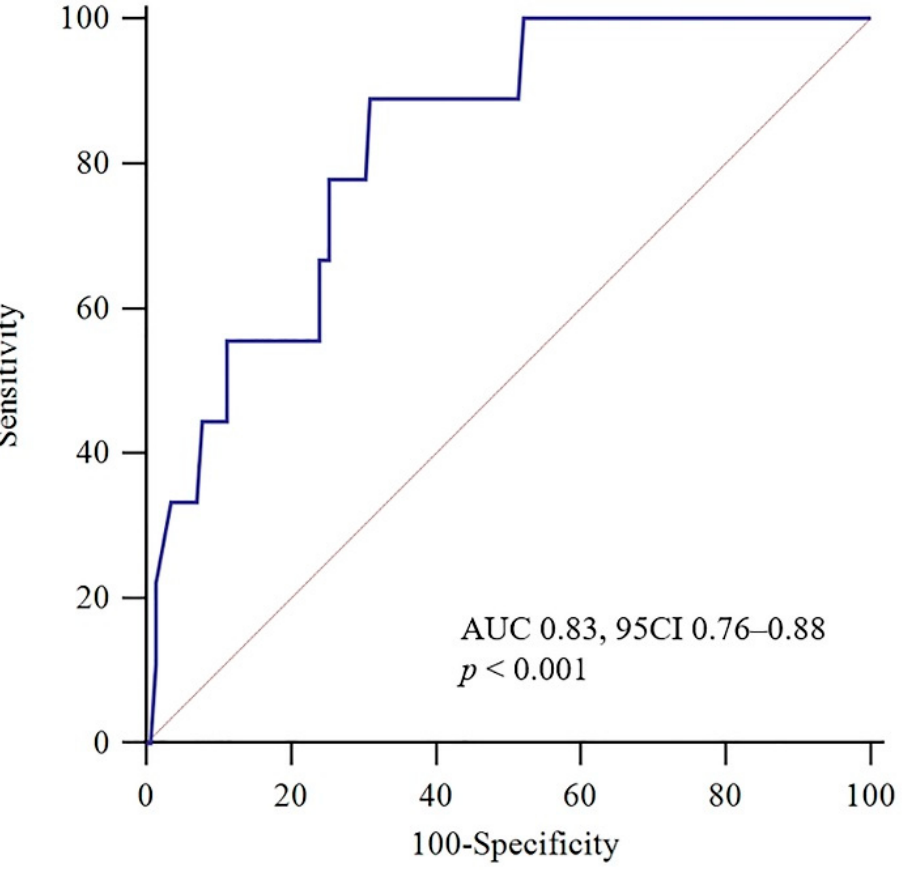
Figure 2. Receiver operating characteristic (ROC) curve for TRAIL concerning an adverse 30-day outcome. AUC: area under the curve; CI: confidence interval.